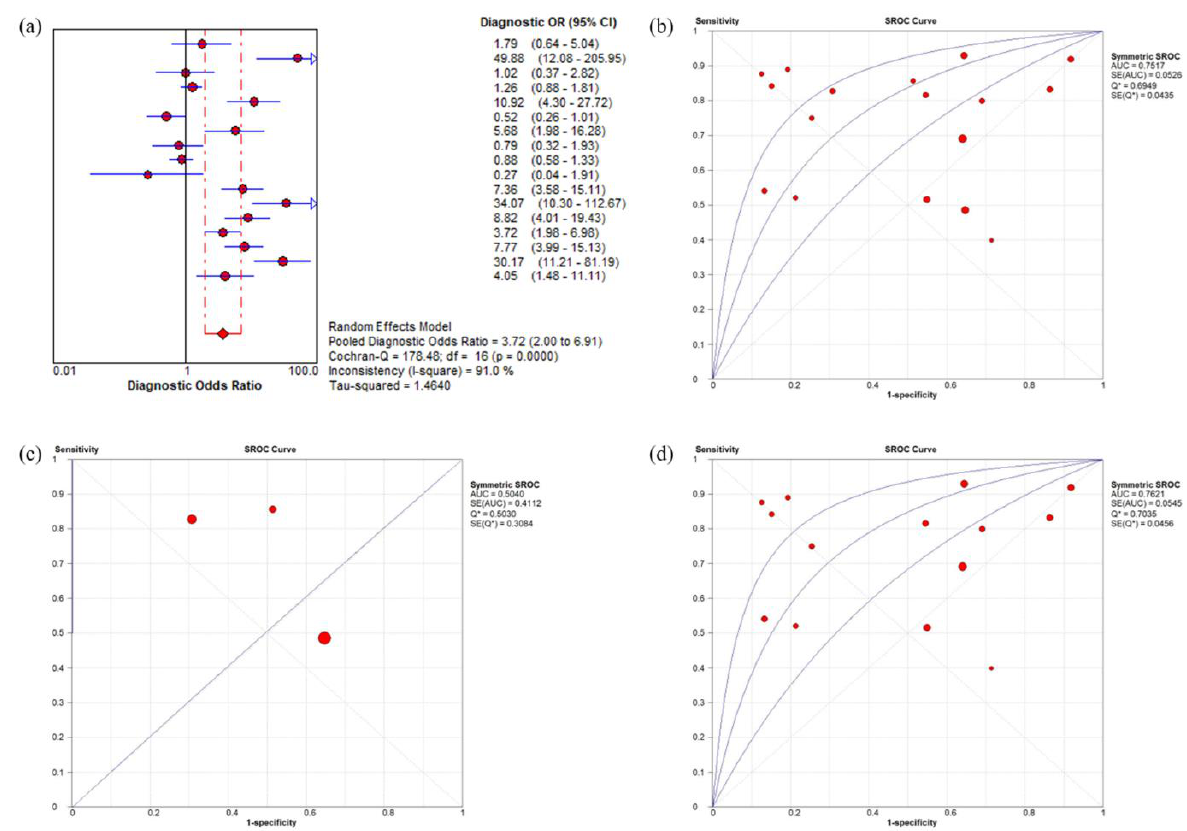
Figure 2. Forest plot of the DOR and the SROC curves of serum IMA levels for diagnosis of ACS. ( a ) The pooled DOR value of the serum IMA levels for diagnosis of ACS was 3.72. ( b ) The area under the SROC was 0.75 in 17 studies. ( c ) When limited to studies assessing AMI, the area under the SROC was 0.50 in three studies. ( d ) For studies that assessed ACS, including UA, the area under the SROC was 0.76 in 14 studies. DOR, diagnostic odds ratio; SROC, summary receiver operating characteristic; IMA, ischemia-modified albumin; ACS, acute coronary syndrome; UA, unstable